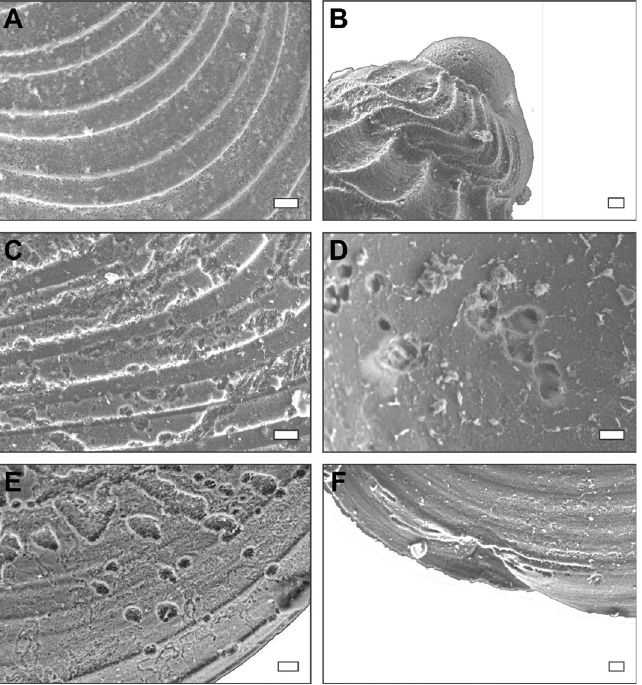
Figure 3. High magnification scanning electron micrographs of representatives of the different states of shell preservation observed in this study. ( A , C – E ) High magnification of Nucinella taylori Foster et al. (2017) 25 shells. ( A ) the pristine shell in Fig. 2A. ( B ) Initial whorl of the Pseduozygopleuridae specimen in Fig. 2D. ( C ) The shell with dissolution pits in Fig. 2D. ( D ) Dissolution pits on the internal surface of the shell in Fig. 2G. ( E ) Dissolution pits and grooves of the shell in Fig. 2B. ( F ) Pectinidae? indet., morphological deformity inferred to have been caused by damage to the shell during growth (magnified from Fig. 2H). Scale bar = 10